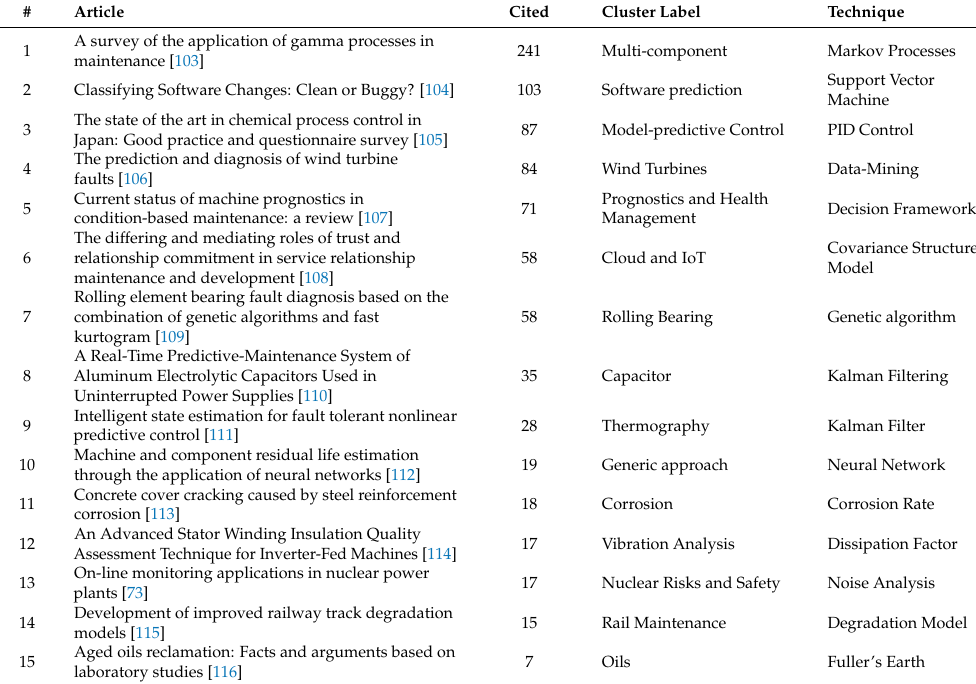
Table A2. Research field and technique of the most cited papers